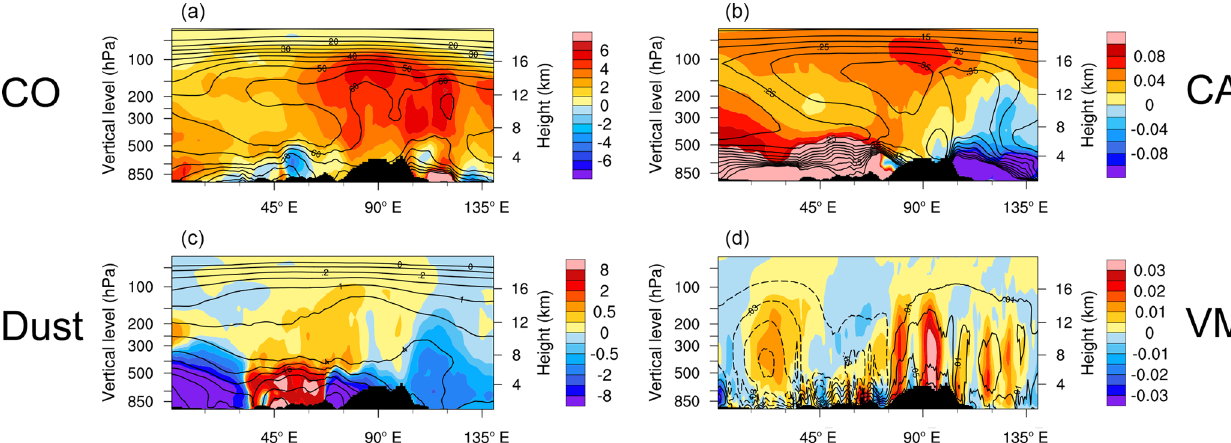
Figure 8. Longitude–height cross sections (0–140 ◦ E) of (a) CO (ppbv), (b) CA (ppbm), (c) dust (ppbm) and (d) vertical motion (Pas − 1 ) anomalies between late part years and early part years (“late” minus “early”) averaged over the southern portion of the AMA (25–35 ◦ N) during July–August, superimposed with the climatological mean of early part years (black contours). For vertical motions in (d) , solid (dashed) contours indicate ascent (descent).